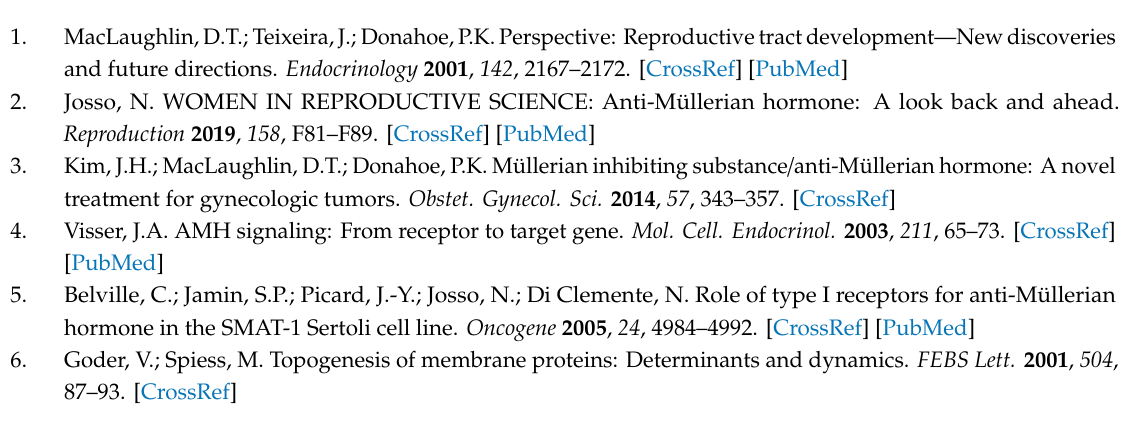
Table S1. Demographic traits of woman distinguished according to the histopathological type of the cancer; in the Table shows: mean ± SD, median (Q2), minimum and maximum values, N—sample size. Table S2. Demographic traits of woman distinguished according to the FIGO classification; in the Table shows: mean ± SD, median (Q2), minimum and maximum values, N—sample size. Table S3. Demographic traits of woman distinguished according to occurrence of diabetes type 2; in the Table shows: mean ± SD, median (Q2), minimum and maximum values, N—sample size. Figure S1. Distribution of AMHRII expression level in groups of patients distinguished according to histopathological type of endometrial lesion; above the figure shows the results of testing the comparison of the distribution with the normal distribution using the Shapiro-Wilk test. Figure S2. Distribution of AMHRII expression level in groups of patients distinguished according to FIGO classification; above the figure shows the results of testing the comparison of the distribution with the normal distribution using the Shapiro-Wilk